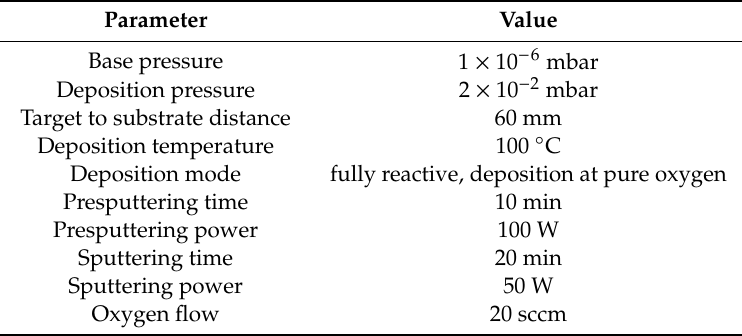
Table 2. The summary of the deposition conditions.